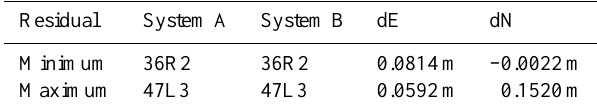
Table 5. Minimum and maximum residuals obtained from the transformation from D¨uzce to Bolu, piers 36 to 47.